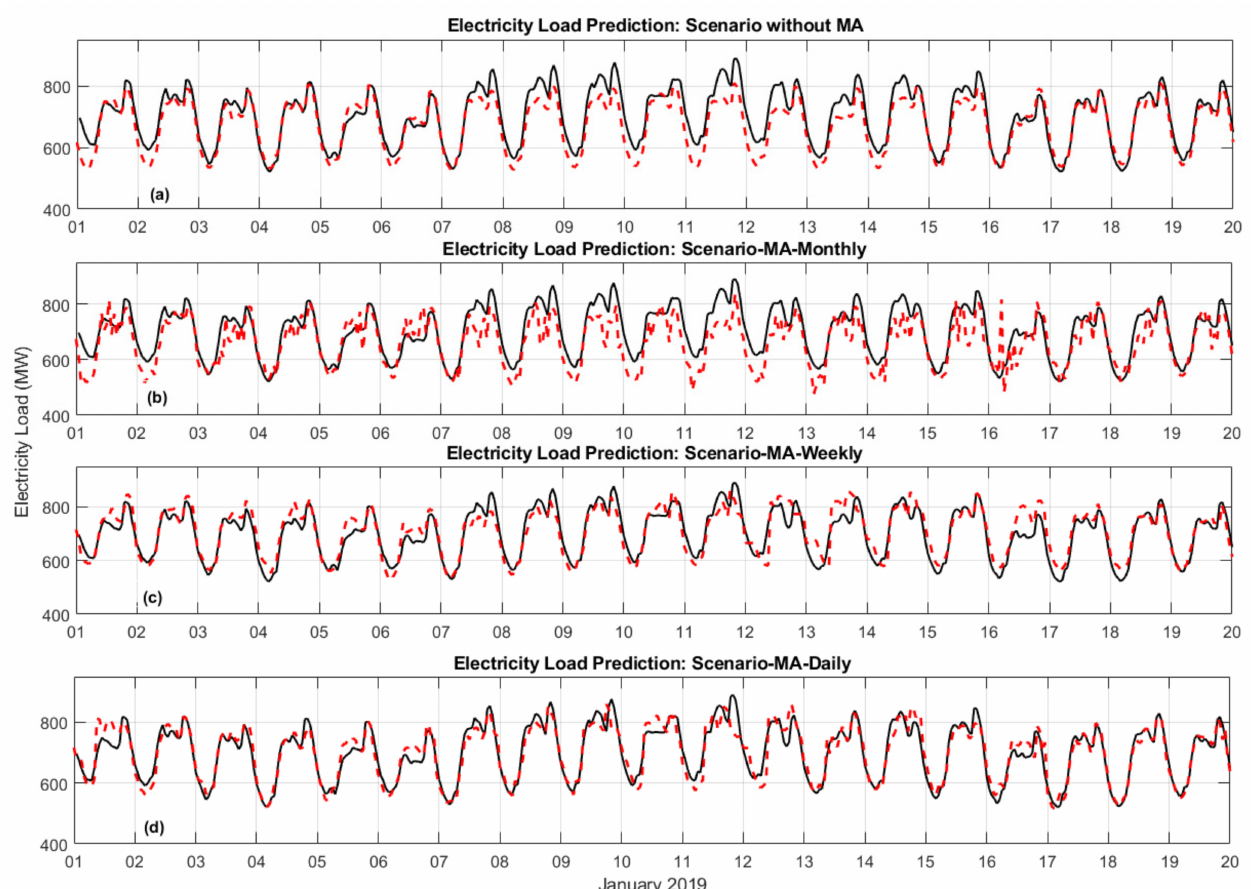
Figure 9. Comparison between electricity load data (solid black line) during the period 1–20 January 2019, with results of prediction by using GRNN model (dashed red line) with various feature moving averaged (M.A.) scenarios; ( a ) scenario without M.A.; ( b ) scenario with MA-Monthly; ( c ) scenario with MA-Weekly; ( d ) scenario with MA-Daily.